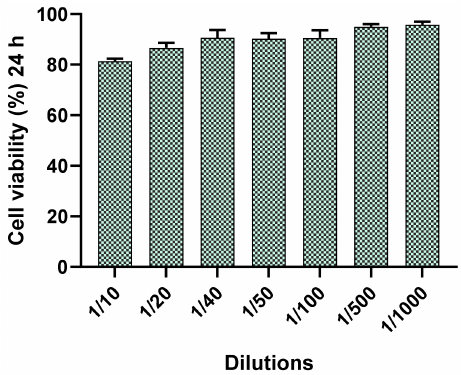
Figure 8. Percentage of cell-viability of HaCaT cell line exposed for 24 h at different